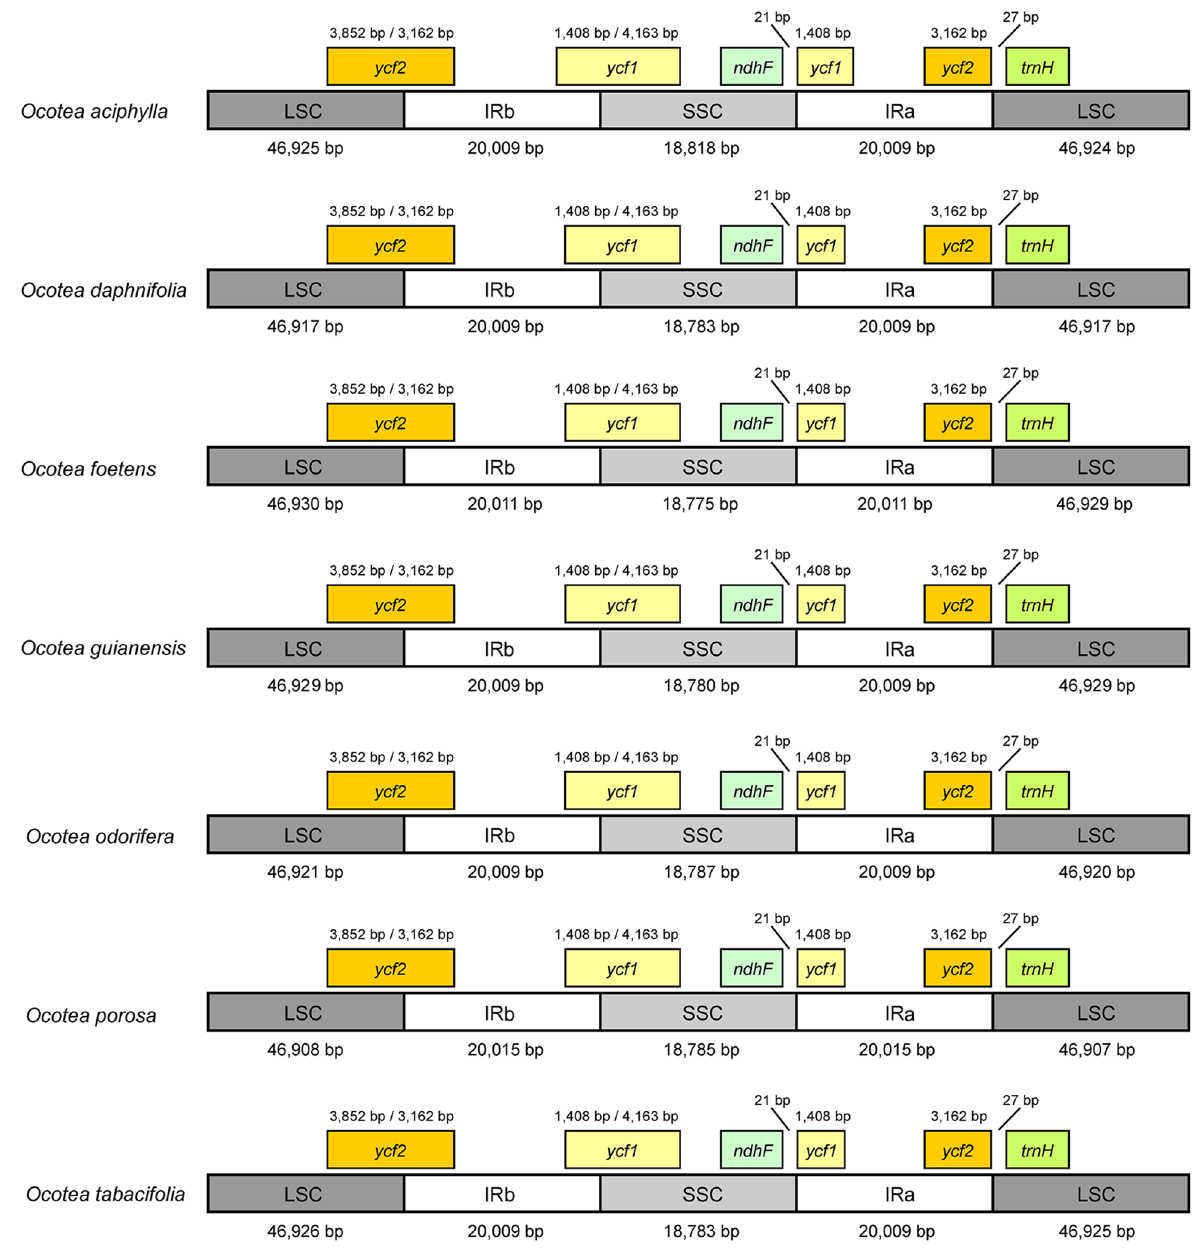
Figure 3. Comparison of LSC, IR, and SSC junction positions among seven Ocotea chloroplast